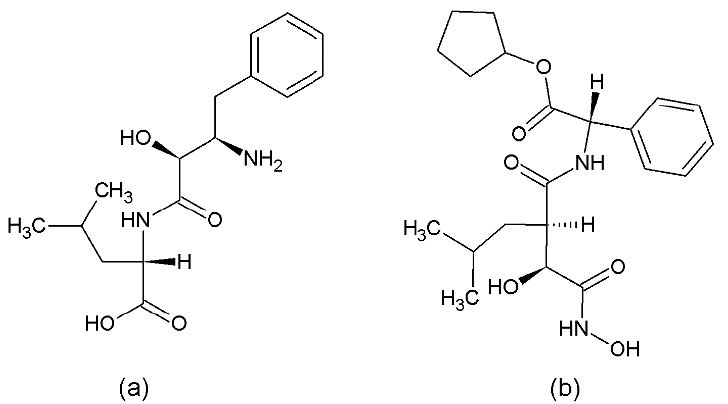
Figure 1. The most known dipeptide APN inhibitors: bestatin ( a ) and tosedostat ( b ). It has undergone more than ten clinical trials of phases 1 or 2 for the treatment of myeloid leukemias and solid tumors. Its anticancer activity is mainly attributed to the inhibition of the cleavage of proteins and peptides by M1 family aminopeptidases including APN. This disrupts normal cellular protein turnover, resulting in both peptide accumulation and a decrease in intracellular free amino acid content, a process that appears to preferentially affect metabolically active cells such as malignant cells. Such an inhibition triggers the phenomenon termed the amino acid deprivation response (AADR), a stress response comprising the upregulation of amino acid transporters and synthetic enzymes and the activation of stress-related pathways such as NFkB and other pro-apoptotic regulators [11]. Death receptor 4 (DR4 or TRAIL-R1), a member of the DR subgroup of the tumor necrosis factor (TNF) receptor superfamily, is overexpressed in various types of tumor cells. DR4 mediates extrinsic apoptotic cascades using binding to TNF-related apoptosis-inducing ligands (TRAIL or Apo2L). Unfortunately, resistance is often observed in the clinical application of TRAIL, which has undergone five clinical trials on its soluble recombinant form dulanermin, and another study for the treatment of peritoneal carcinomatosis continues [12]. In a recent study, bestatin markedly sensitized fibrosarcoma cells previously implanted in athymic nude mice to apoptosis induced by TRAIL [13].